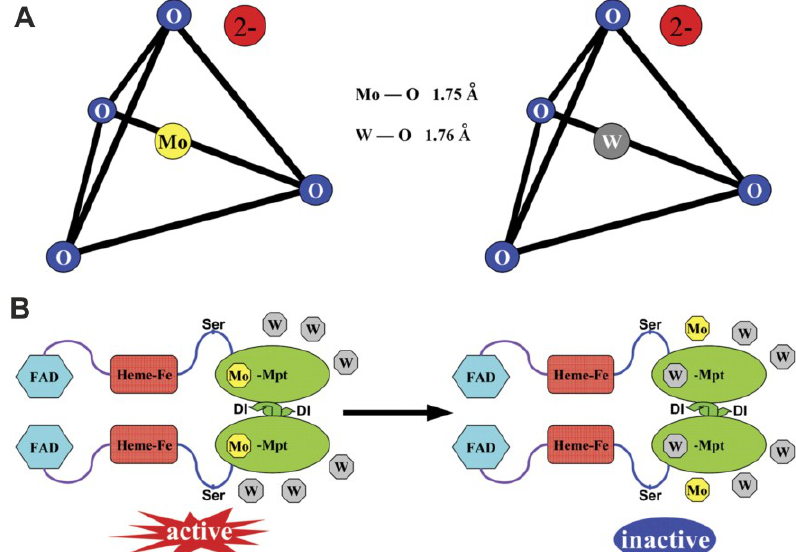
Figure 1. A comparison of tungstate and molybdate structure that underlies their antagonism for molybdenum cofactor (MoCo). ( A ) Structural schemes of tungstate and molybdate. The metal atoms are at the centre of a tetrahedron of oxygen atoms. ( B ) Tungstate competes with molybdate for incorporation into the MoCo, resulting in inactivation of nitrate reductase (NR). FAD: flavin adenine dinucleotide, Mo-Mpt: molybdenum-molybdopterin. Reprinted from [29], with kind permission from both the authors and Oxford University